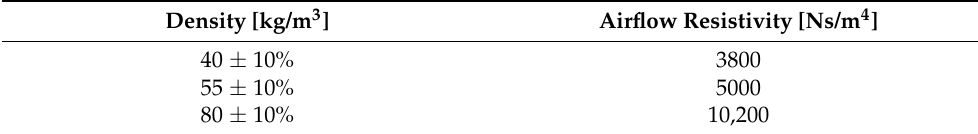
Table 1. Experimentally obtained values for the flow resistivity of the considered RPUFs. Density [kg/m 3 ]